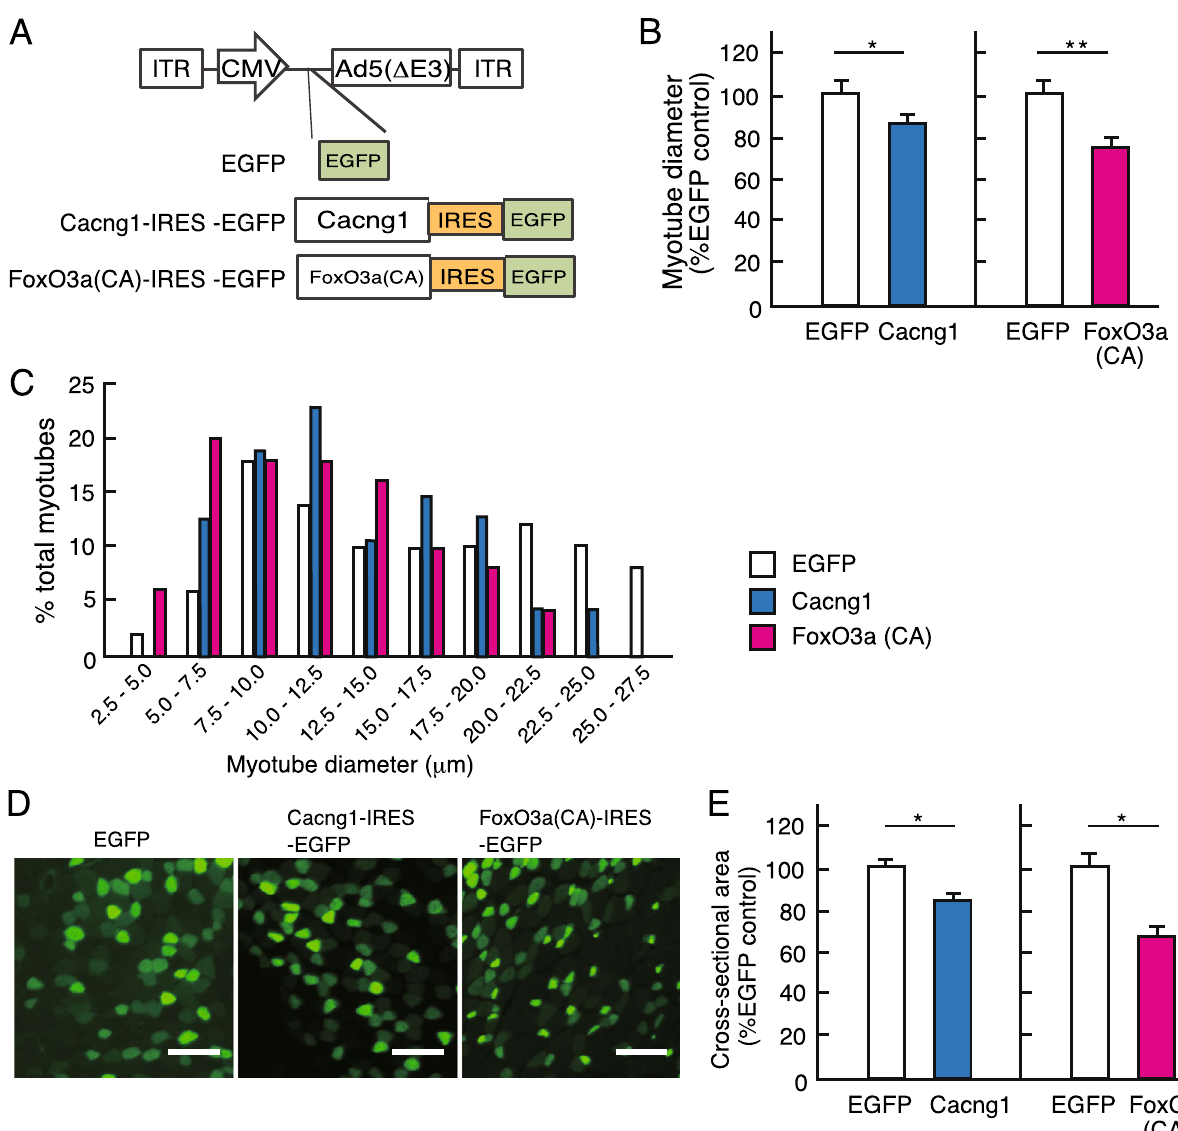
Figure 5. Functional validation of candidate genes using culture cell and neonatal mice muscle. ( A ) Construction of adenovirus vectors, only EGFP, Cacng1-IRES-EGFP, and FoxO3a (constitutive active; CA)- IRES-EGFP. ( B ) Quantification of the myotube diameters of C2C12 myotubes expressing EGFP, Cacng1- IRES-EGFP, and FoxO3a(CA)-IRES-EGFP. P -value from Student’s t -test is indicated as follows: * P < 0.05 and ** P < 0.01. ( C ) Frequency distribution of myotube diameters in C2C12 myotubes expressing EGFP, Cacng1- IRES-EGFP, or FoxO3a(CA)-IRES-EGFP. ( D ) Representative cross-sectional areas of TA muscles expressing EGFP (Green) after the transfection of EGFP, Cacng1-IRES-EGFP, or FoxO3a(CA)-IRES-EGFP. Scale bars indicate 50 μm. ( E ) Bar diagrams showing the cross-sectional area of TA muscles expressing EGFP. P -value from Student’s t -test is indicated as follows: * P < 0.05. Three independent infections were performed in three